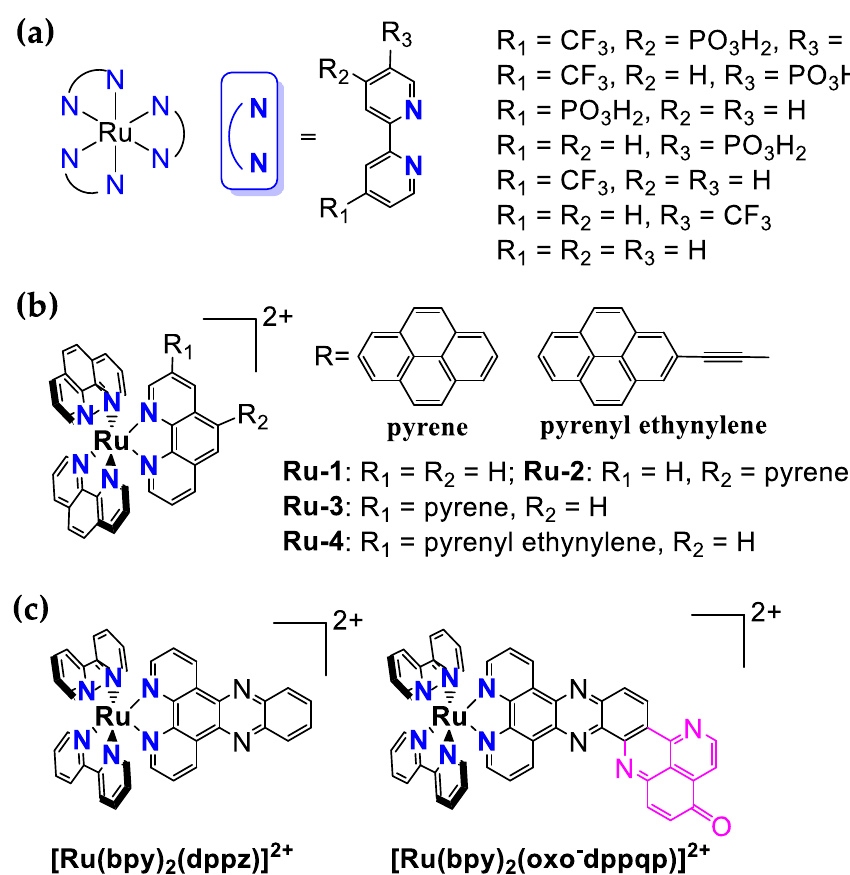
Figure 4. Chemical structures of the ( a ) [Ru(bpy) 3 ] 2+ -based, ( b ) [Ru(phen) 3 ] 2+ -based, and ( c ) [Ru(bpy) 2 (dppz)] 2+ -based photosensitizers and corresponding ligands in this